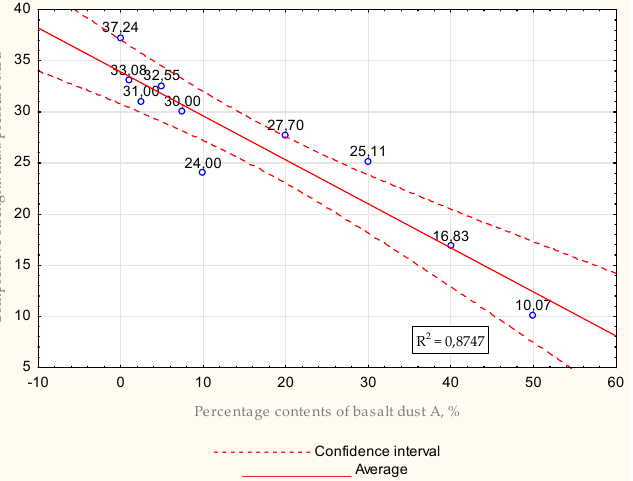
Figure 22. Average values received during compressive strength tests for water − mix ratio = 0.6, maximal pressure. The compressive strength values of the cement slurries for all tested formulas were lower than those of the zero sample. The closest to the zero sample was the formula con- taining 5% dust in its composition, for which the values were about 1.5% lower. For the other samples, the compressive strength values were reduced in the range of 6–37% com- pared to the zero sample.